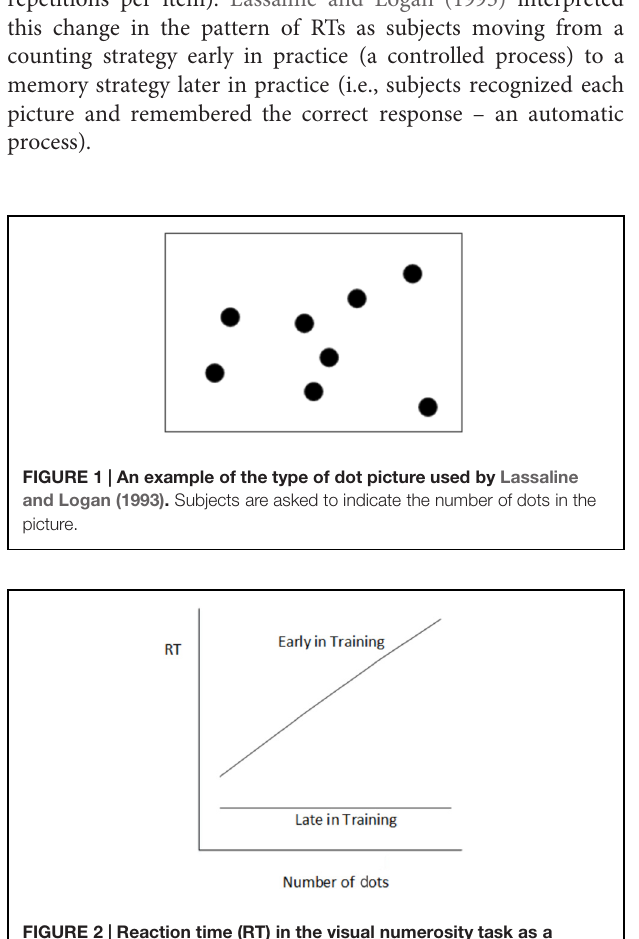
FIGURE 2 | Reaction time (RT) in the visual numerosity task as a function of number of dots in each stimulus